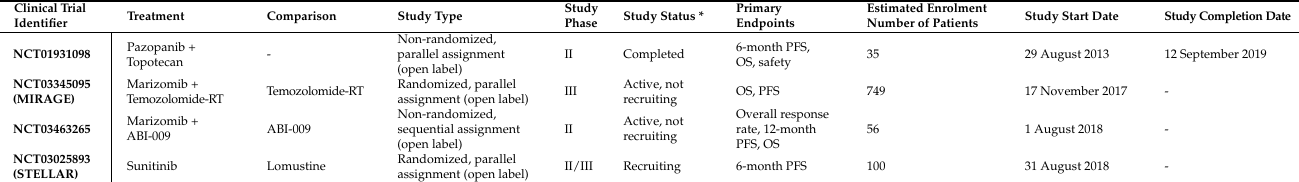
Table 2. Ongoing clinical trials evaluating anti-angiogenic therapies in